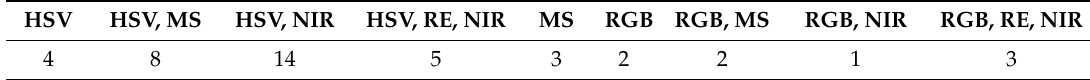
Table 5. Point-based ranking of sets of data channels.